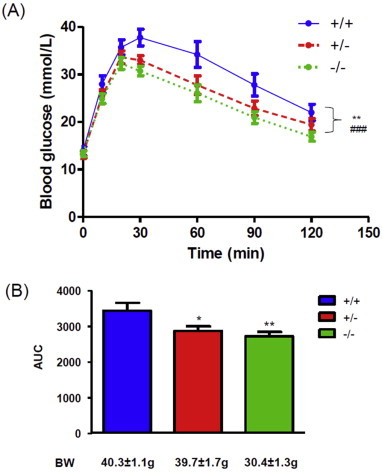
The ability of WT and Fto-deficient male mice on chow and a HFD to reduce food intake in response to an intracerebroventricular (icv) injection of leptin. A single injection of 500 ng of leptin was administered centrally and food intake was measured 4 h after food was returned to the hopper. (A) Leptin administration decreased food intake significantly in all mice on standard chow (Fto+/+ n = 8, Fto+/− n = 11, Fto−/− n = 6). (B) Leptin-induced anorexia is absent in WT mice with 5 weeks of high-fat feeding but retained in Fto-deficient mice (Fto+/+ n = 10, Fto+/− n = 15, Fto−/− n = 7). Data are plotted as grams of food consumed for the 4 h duration post saline or leptin injection. *p < 0.05; **p < 0.01; ***p < 0.001; NS = not significant following one-tailed t-test.